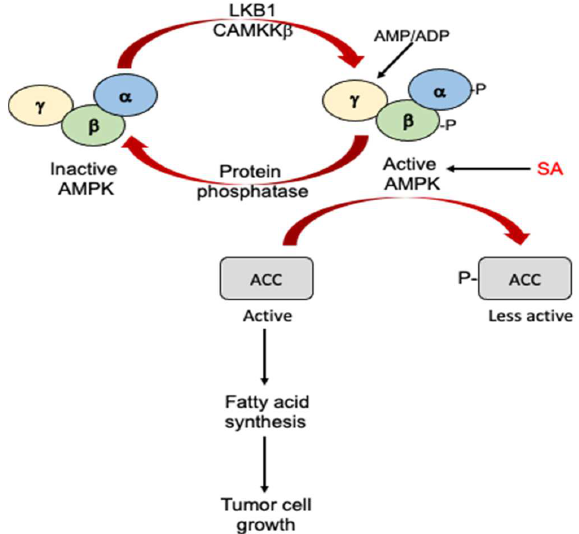
Figure 4. Antitumor activity of SA through activation of AMPK. AMPK is activated through phos- phorylation of its α and β subunits by LKB1 and CAMKKβ or through allosteric effects on its γ subunit by AMP/ADP. SA can directly bind to and activate AMPK. Activated AMPK phosphorylates and inactivates ACC. Inactivated ACC suppresses fatty acid synthesis and tumor cell growth. As a conserved enzyme, PP2A is not only directly targeted by SA in plants but is also subjected to regulation by aspirin in animals. Aspirin displays chemopreventive efficacy in colon cancer, which appear to be associated with the effects of aspirin on the oncogenic Wingless-related integration site (Wnt)/β-catenin pathway activity in colorectal cancer cell lines [99]. Wnt/β-catenin signaling is initiated by the binding of extracellular cysteine-rich